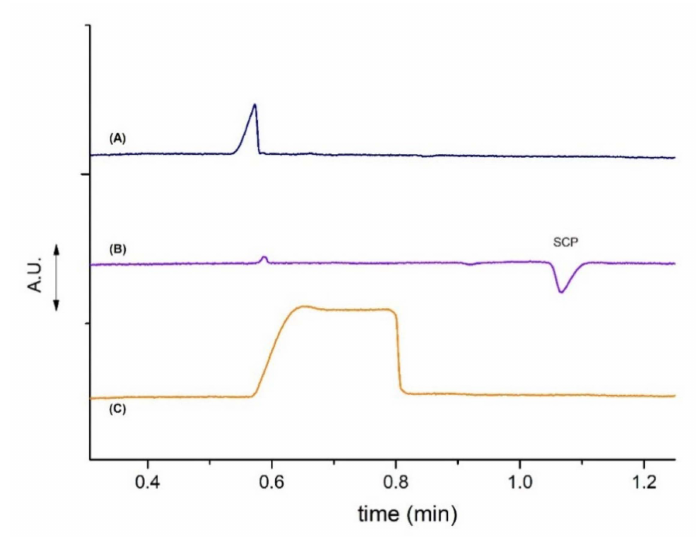
Figure 2. Representative electropherograms of a synthetic urine sample submitted to the MISPE-DPX- CE procedure before ( A ) and after ( B ) spiked with SCP (6 µ M) and, ( C ) synthetic urine sample without submission to the MISPE-DPX-CE procedure and also spiked with SCP (6 µ M). BGE: 20 mmol L − 1 of butyric acid with 7 mmol L − 1 NaOH (pH = 4.5). C4D detector positioned at 10 cm along the